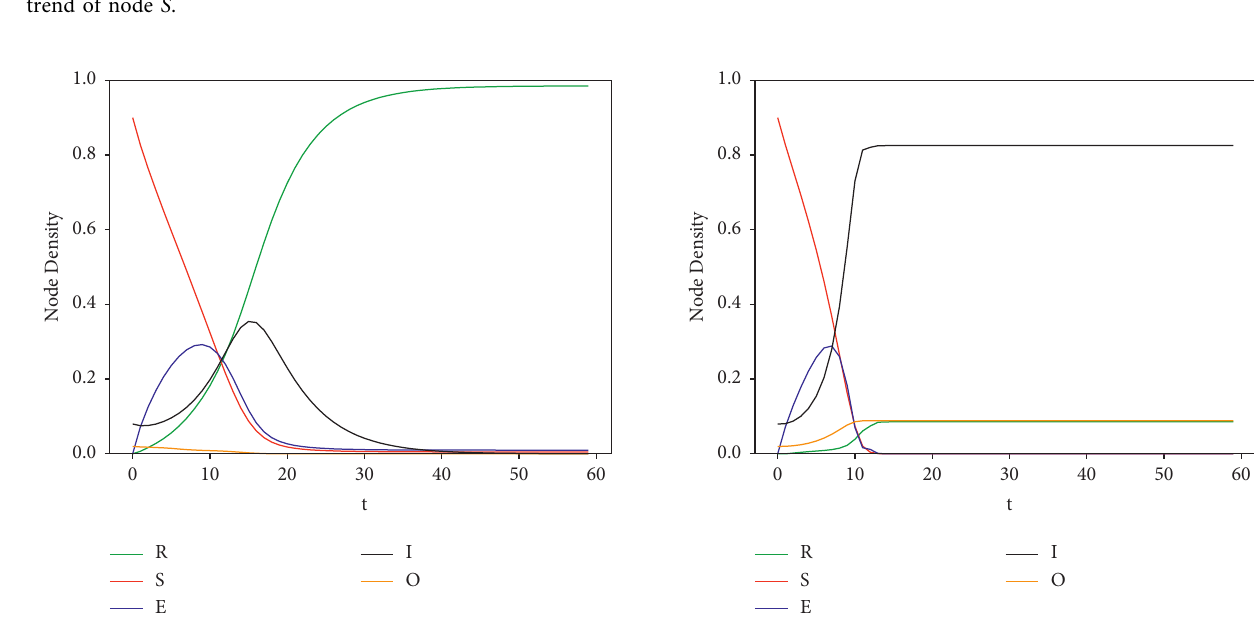
Figure 7: System evolution trend when incomes are always greater than